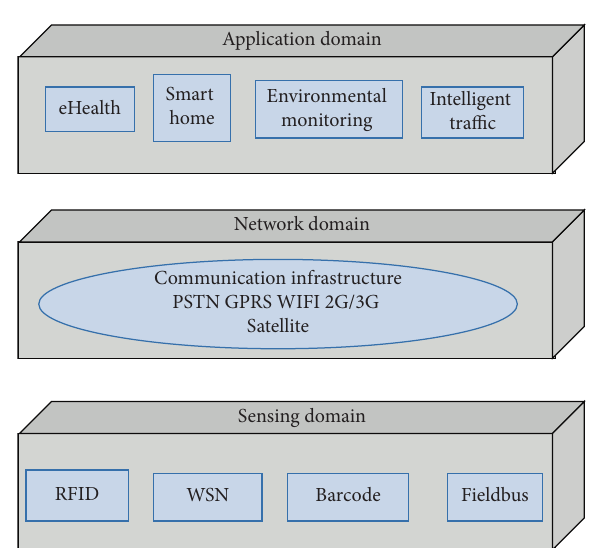
Figure 4: Domains of IoT